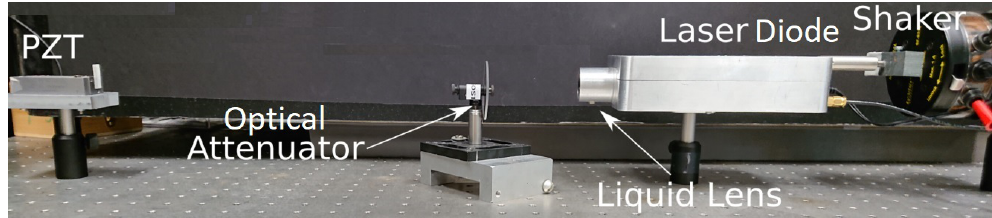
Figure 13. Photograph of the experimental setup for SMI-based sensing. In Figure 14, we present different experimental speckle affected SMI signals. We have shown an enlarged view of one segment of each of these SMI signals in Figure 14b. Each segment shows variable optical feedback conditions where C value and signal amplitude is varying. As can be seen from Figure 14c,d, both the trained DNNs are able to correctly detect and classify positive and negative class fringes under experimental VOF conditions.